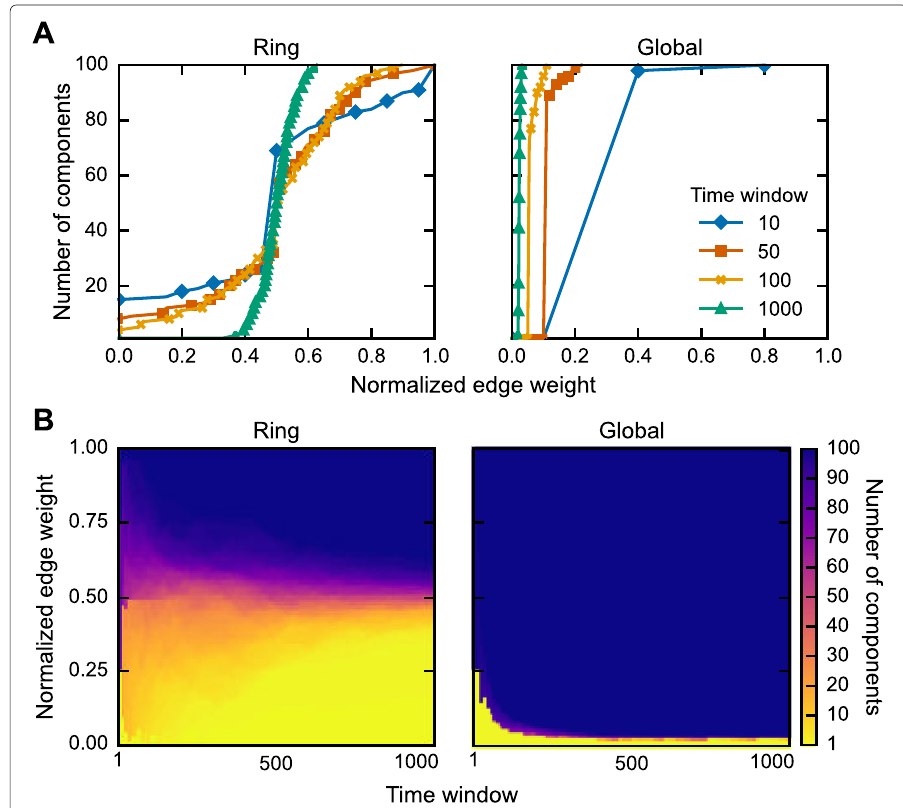
Fig. 7 The impact of the removal of the edges on the growth of the number of components depends on the structure of the swarm topology. ( a ) The rapidly increasing in the number of components of the global topology leads to a type of behavior related to the exploitation search mode. In the ring topology, the number of components increases slowly, indicating the existence of sub-swarms searching more independently through the search space (Oliveira et al. 2014). The different colors/markers in the plot represent the time window t w . The normalized weight is the weight value divided by 2 t w , which is the highest possible weight in the network. In all cases, the swarm consists of 100 individuals. ( b ) Each topology leads to distinct interaction diversity that can be described by the number of components emerging (color intensity) as edges are removed ( y -axis) of the interaction network with different time windows ( x